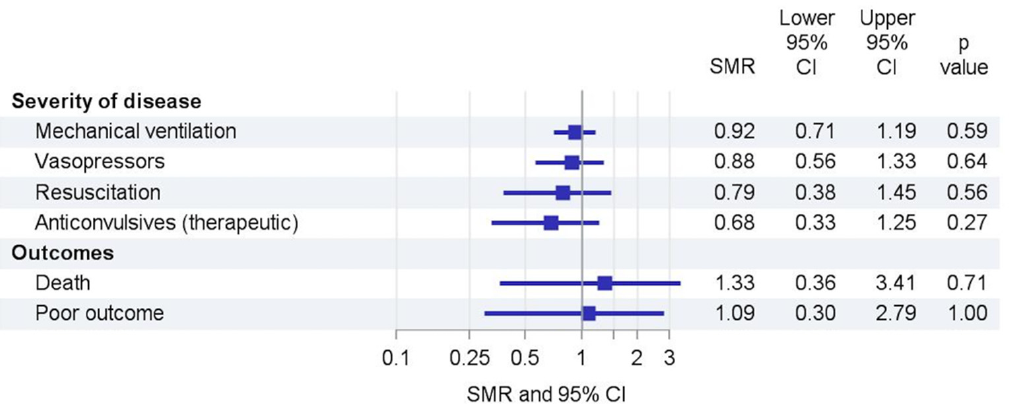
Figure 3. Trends in severity of disease and outcomes. SMR, standardized morbidity rate; CI, confi- dence interval.